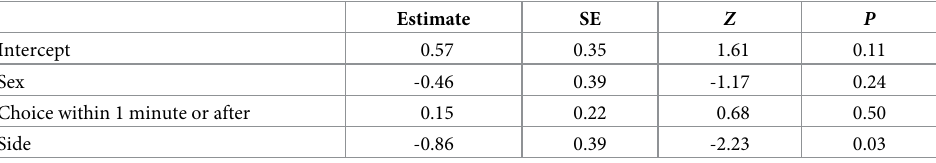
Table 4. Model for bird choice in relation to: The difference in the MHC-I functional distance between the focal birds and the two scent donor birds of the opposite sex (as a dichotomous variable: Greater MHC-I functional dis- tance (yes) vs. lower MHC-I functional distance